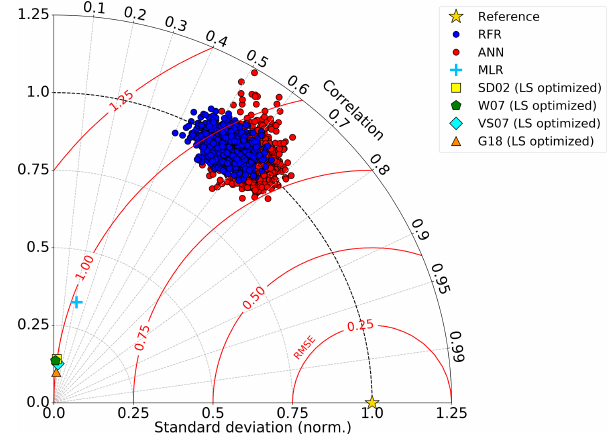
Figure 2. Taylor diagram showing comparative performance met- rics of each individual random forest regression (RFR) and artifi- cial neural network (ANN) model (1000-model ensembles) against multiple linear regression (MLR) and other statistical DMS models (see Sect. 2.1 and 2.4). The Pearson correlation coefficients (“Corre- lation”; outer radius), root mean squared error (“RMSE”; red radial contours), and standard deviations (SDs; grey radial contours from origin) are all computed with respect to the observed DMS sam- ples after inverse hyperbolic sine (IHS) transformation. The refer- ence of a perfect model fit is shown with a gold star. SDs of the model outputs are normalized to the SDs of the DMS observations. RMSE represents a normalized trigonometric derivation from both the correlation coefficients and normalized SDs. Performance of the SDO2, W07, VS07, and G18 algorithms reported here are calcu- lated using regionally tuned coefficients to the NESAP derived from non-linear least squares optimization (see Sect.